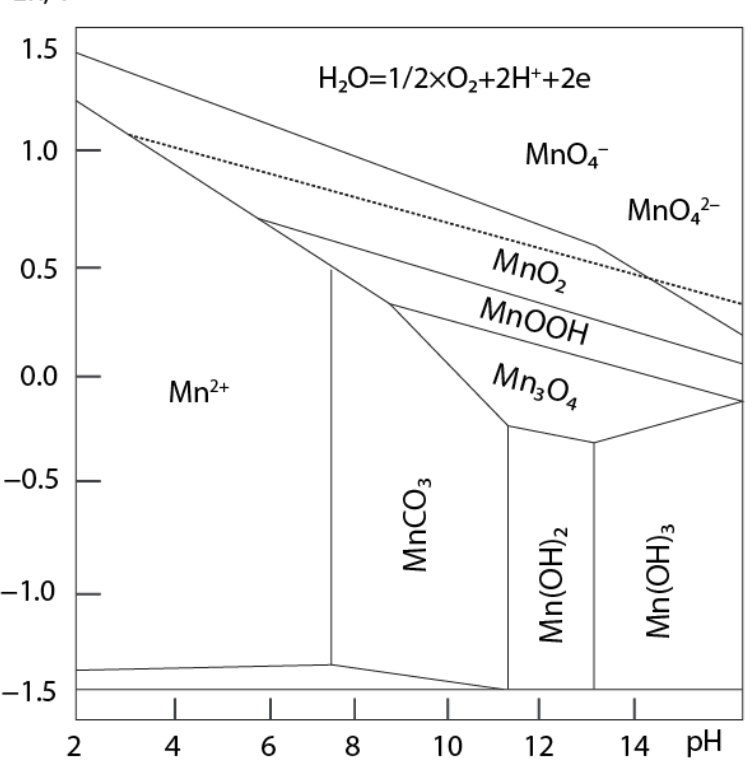
Figure 4. Modes of occurrence of Mn depending on the values of Eh and pH at +25 °С. Modified after E.P. Nakhshina and N. Takeno [85,86].